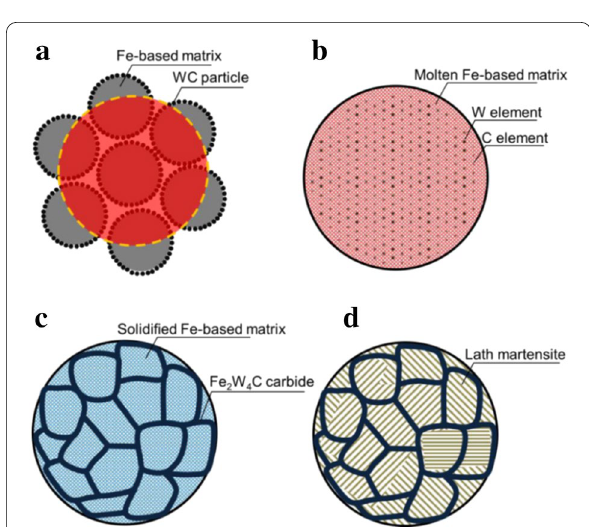
Figure 11 Mechanism of the solidification process during laser AM IMCs